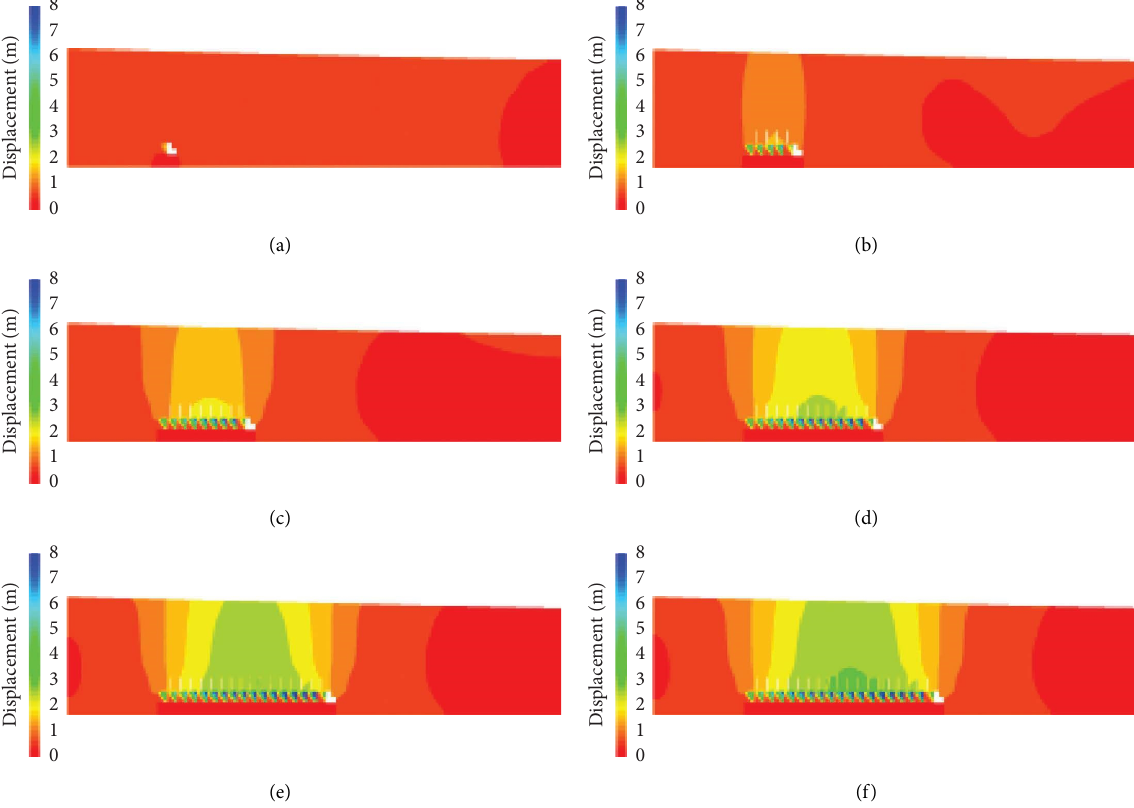
Figure 6: Overlying rock migration characteristics of ultra-high working face under diferent advancing distances: (a) advance 32m, (b) advance 96m, (c) advance 160m, (d) advance 224m, (e) advance 288m, and (f) advance